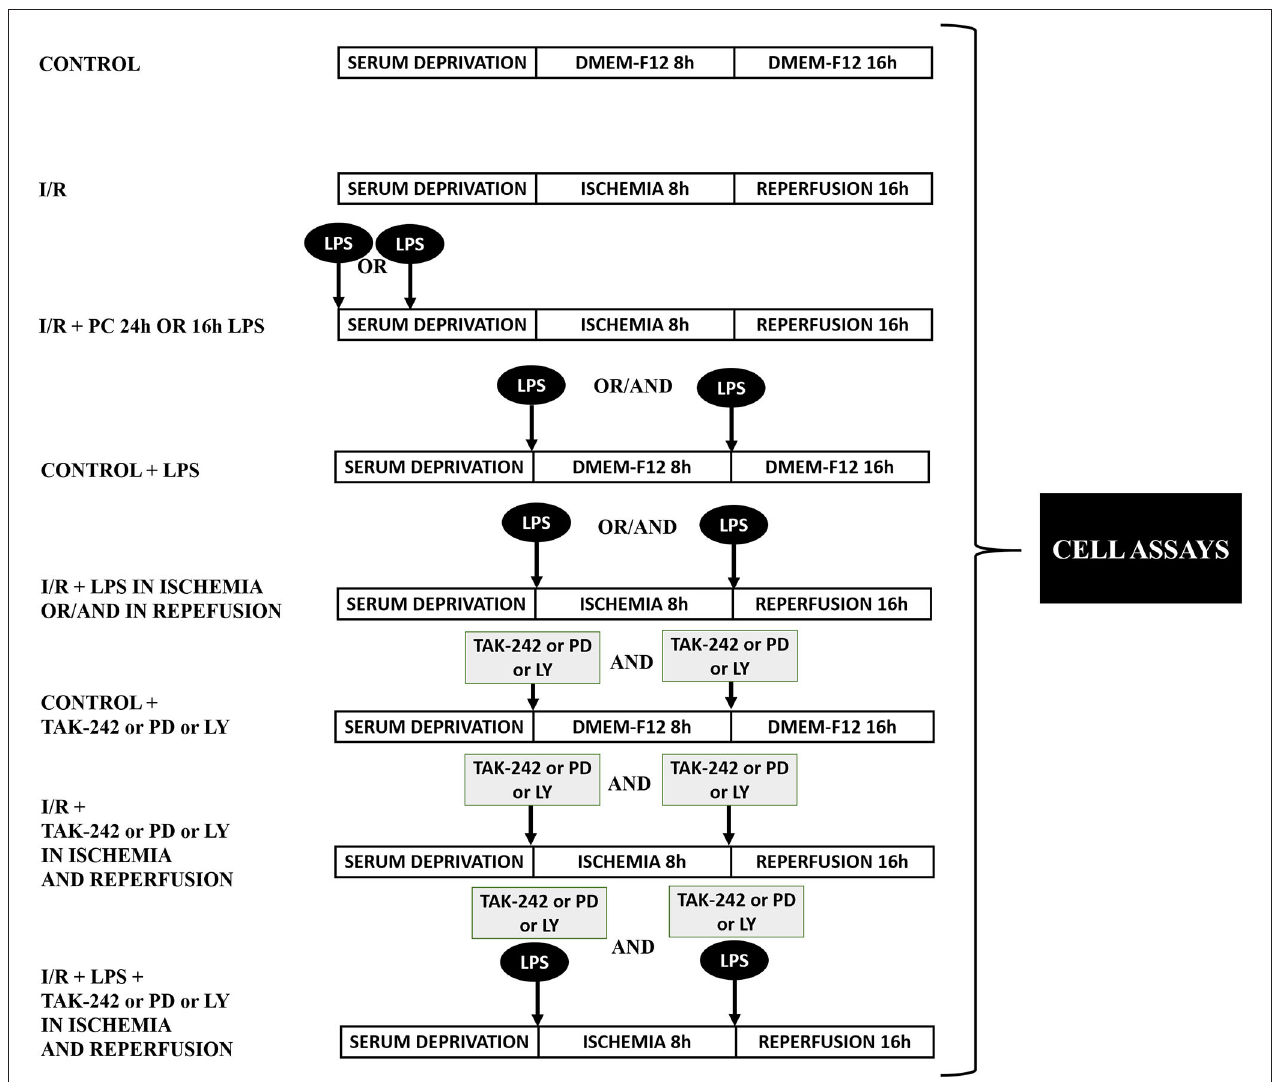
FIGURE 1 | Protocol of experimental design. Representative diagram of the experimental groups in the biological